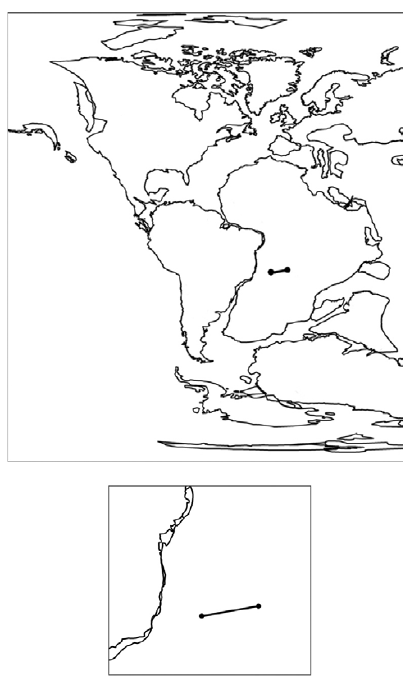
Fig. 9 - Paleogeographic map showing the individual track of Mawsonia gigas in Albian/Cenomanian, with a zoom of the occurrences